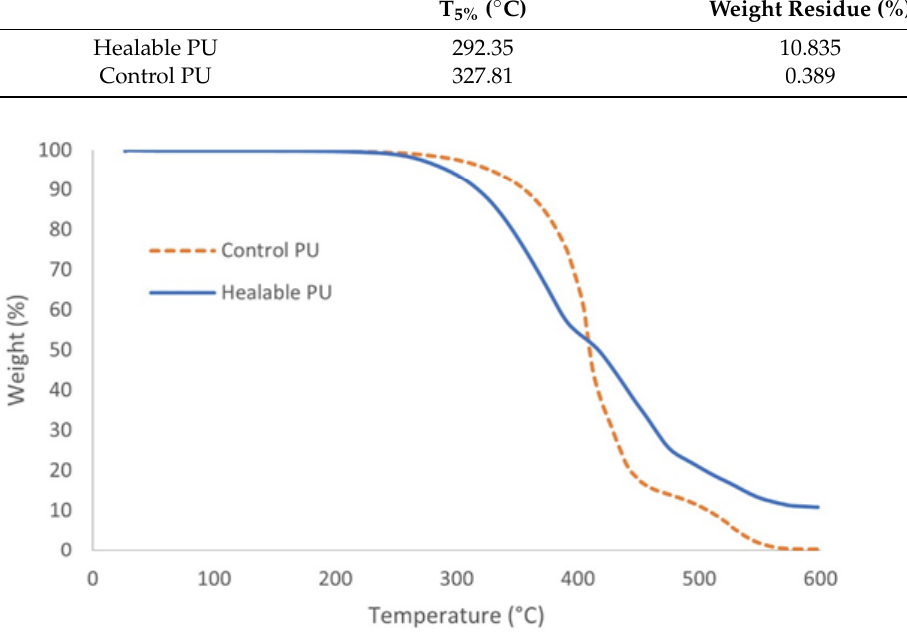
Figure 6. TGA curves of bio-based 2K PU coatings in air.